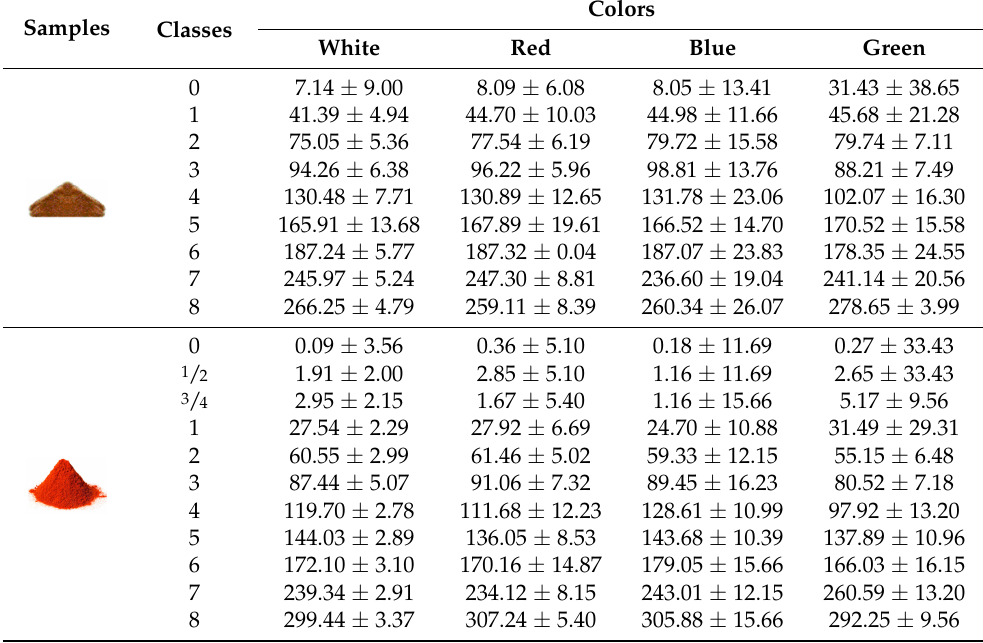
Table 7. Turbidity measured with the proposed method. It shows mean values ± standard devi- ation of the turbidity estimated by the CNN + MLR for each color dataset for the fish feed and paprika samples.